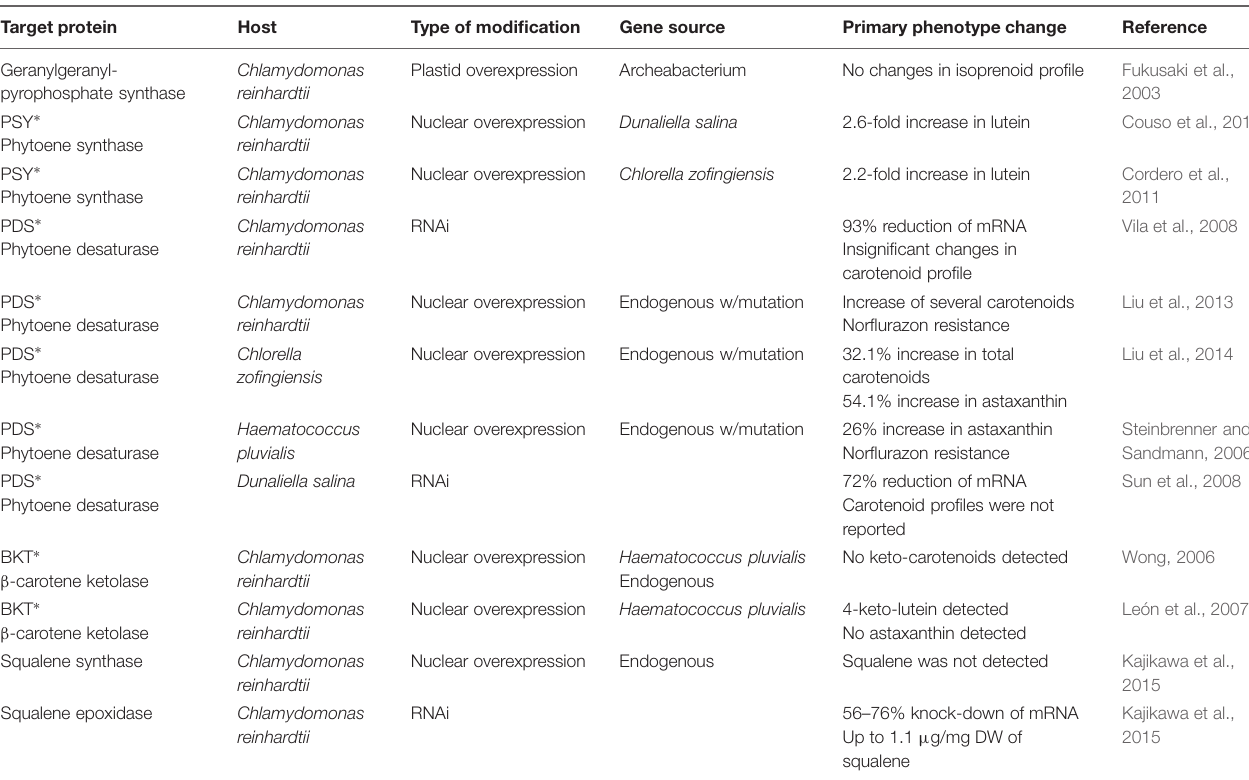
TABLE 2 | Metabolic engineering reports for terpenoid biosynthesis in